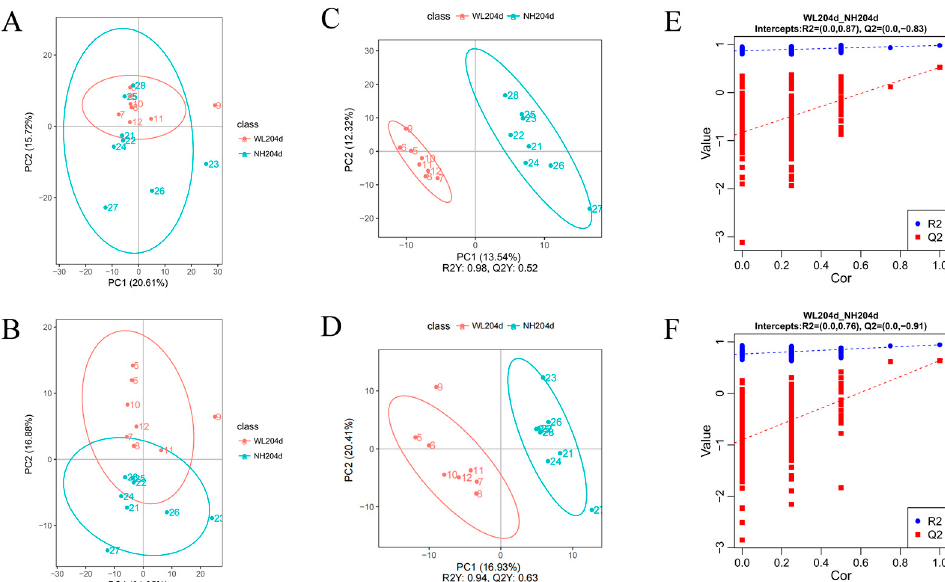
Figure 2. Metabolome quality control analysis. ( A ) PCA analysis in the negative model; ( B ) PCA analysis in the positive model; ( C ) PLS-DA analysis in the negative model; ( D ) PLS-DA analysis in the positive model; ( E ) permutation test of PLS-DA in the negative model; ( F ) permutation test of PLS-DA in the positive model.